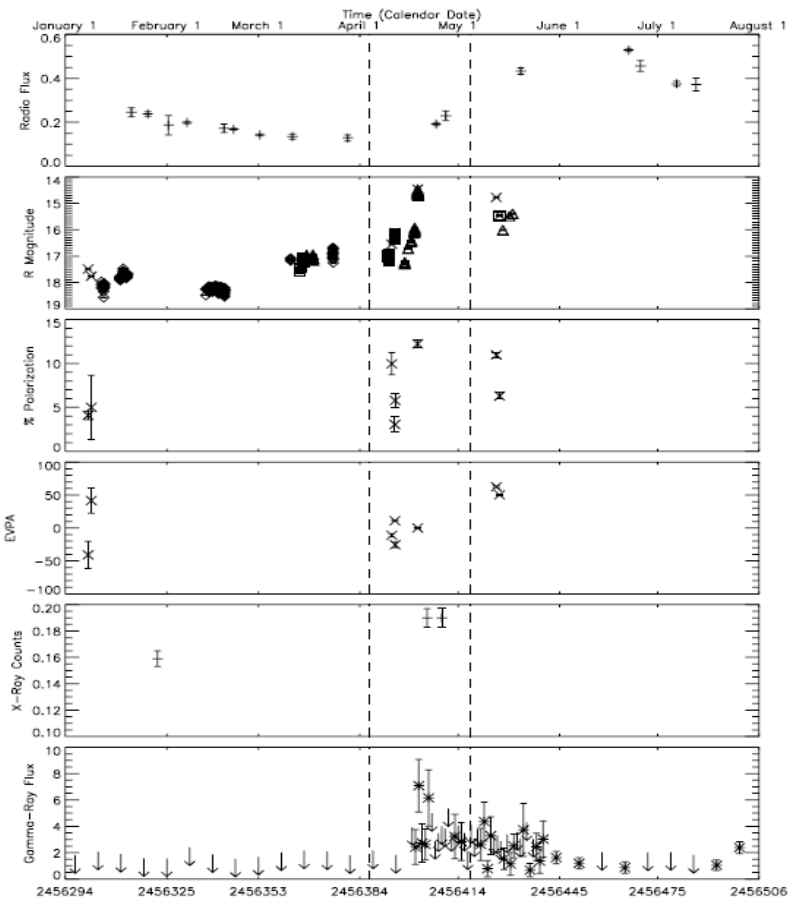
Figure 5. Multiwavelength observations of J0849+0022 from the year 2013, combining data from the Owens Valley Radio Observatory, Lowell (optical R band), Swift (X-ray), and Fermi (gamma-ray) telescopes. The dotted lines indicate a period in which there was a gradual 30% increase in IR flux, reported by Mexico’s National Institute for Astrophysics, Optics, and Electronics (Carrasco et al. [16]).